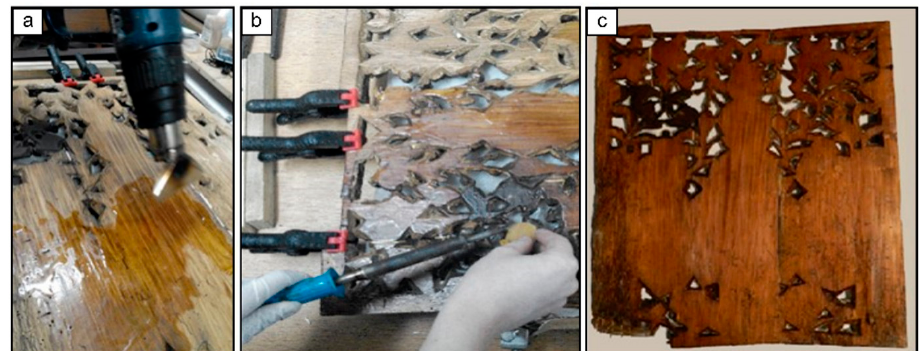
Figure 8. Hot impregnation with beeswax and colophony: ( a ) Impregnation of the surface of the reverse with a hot air blower; ( b ) Impregnation of carved and perforated areas with an electric spatula ( c ). The reverse image after the total impregnation.